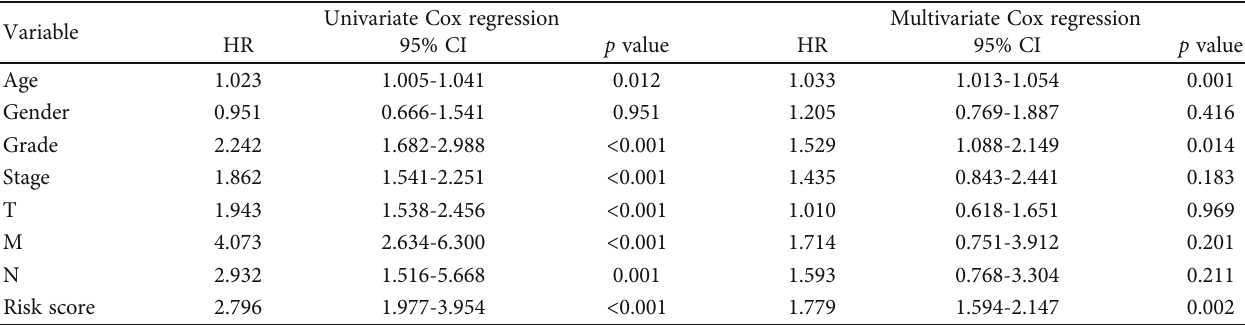
Table 4: Univariate and multivariate Cox regression analyses of the TCGA cohort for risk score of m 5 C-related genes.